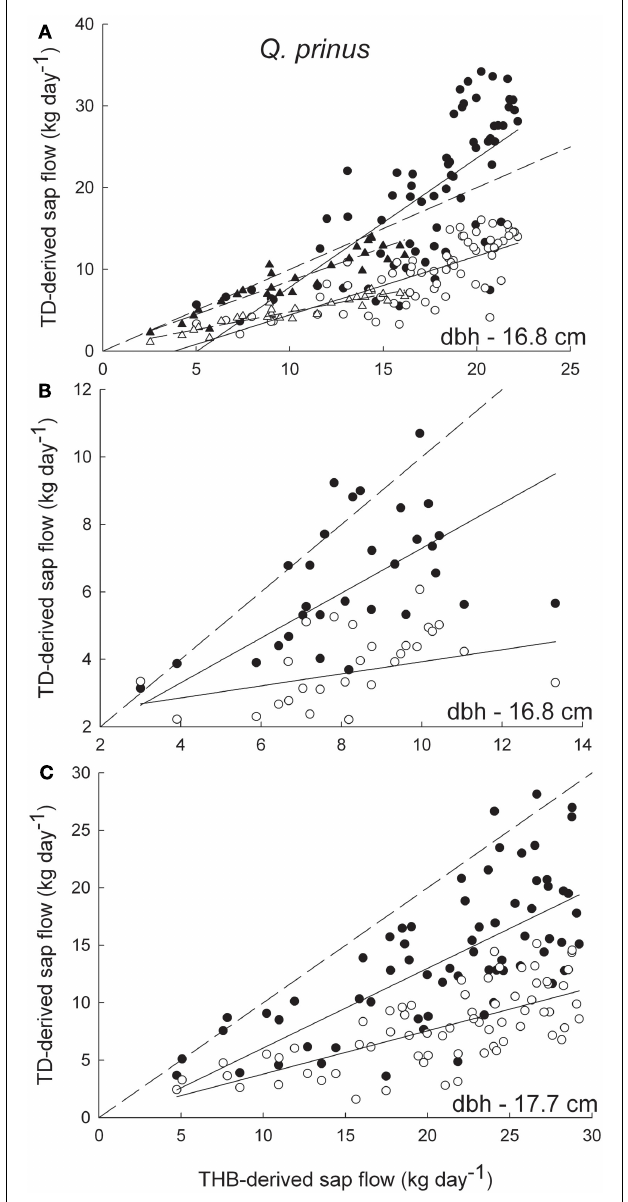
FIGURE 1 | Sap flow rates (kgday − 1 ) for Q. prinus derived from the tissue heat balance (THB) system and thermal dissipation (TD) system using 2-cm long sensors for (A) a 16.8-cm dbh individual, (B) a 16.8-cm dbh individual, and (C) a 17.7-cm dbh individual. Open symbols denote sap flow rates derived from the original Granier equation and closed symbols are sap flow rates with the Clearwater correction applied. Circles denote flow rates measured in 2009 and triangles (A) denote flow rates measured in 2010.The dashed lines are the one to one lines for each graph. The solid lines are the best fit regressions for (A) 2009 uncorrected data ( y = 0.72 x − 2.7, r 2 = 0.57), 2009 Clearwater-corrected data ( y = 1.58 x − 7.9, r 2 = 0.54), 2010 uncorrected data ( y = 0.43 x + 0.48, r 2 = 0.87), 2010 Clearwater-corrected data ( y = 0.82 x + 0.42, r 2 = 0.86), (B) 2009 uncorrected data ( y = 0.18 x + 2.1, r 2 = 0.12) and 2009 Clearwater-corrected data ( y = 0.66 x + 0.65, r 2 = 0.43), and (C) 2009 uncorrected data ( y = 0.38 x + 0.04, r 2 = 0.48) and 2009 Clearwater-corrected data ( y = 0.69 x − 0.87, r 2 =